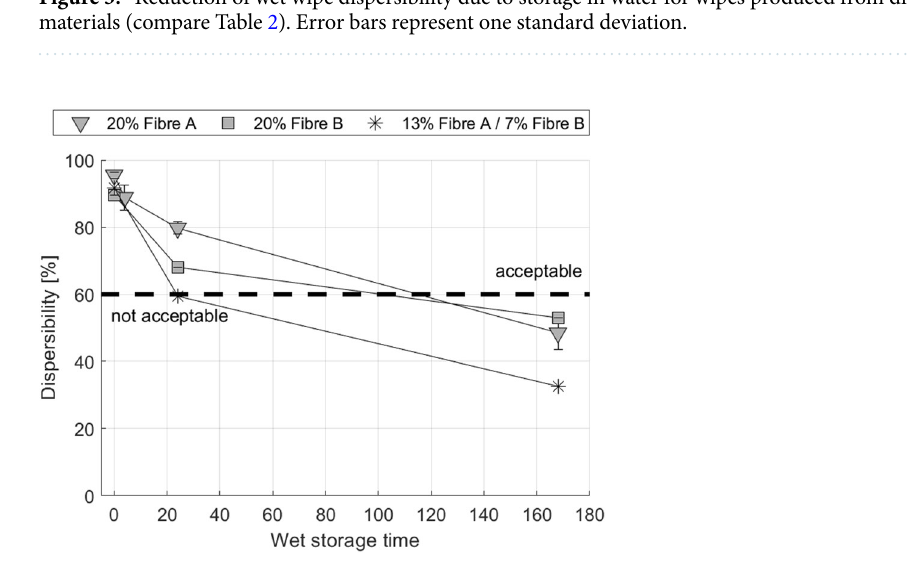
Figure 4. Reduction of wet wipe dispersibility due to storage in water for wipes from industrial pilot production. The same bleached kraft pulp was used in all samples and the viscose fibre was altered. All